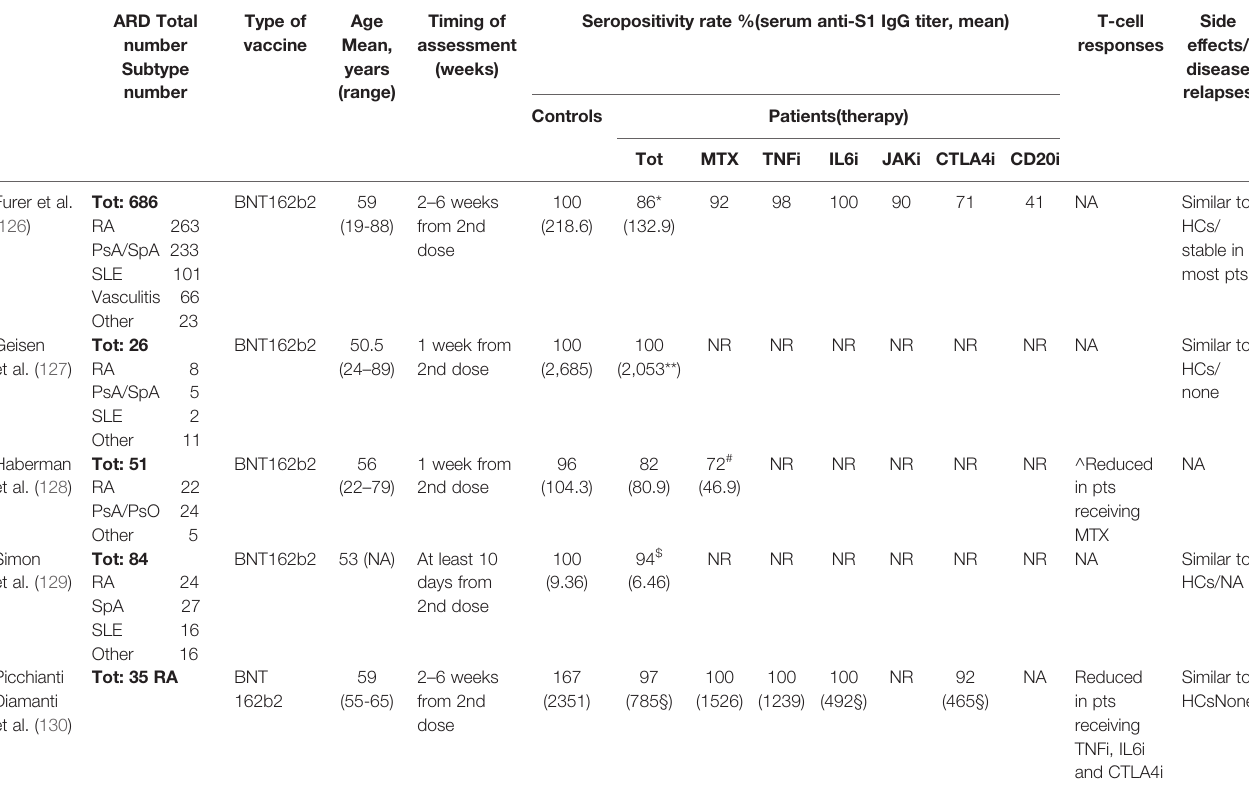
TABLE 1 | Core relevant data from studies evaluating ef fi cacy and safety of SARS-CoV-2 vaccine in ARD